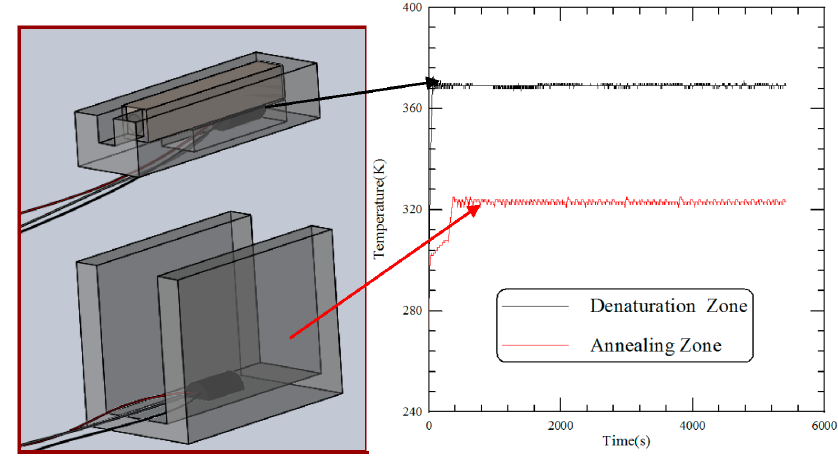
Figure 5. The transient temperature profiles of two thermal blocks.